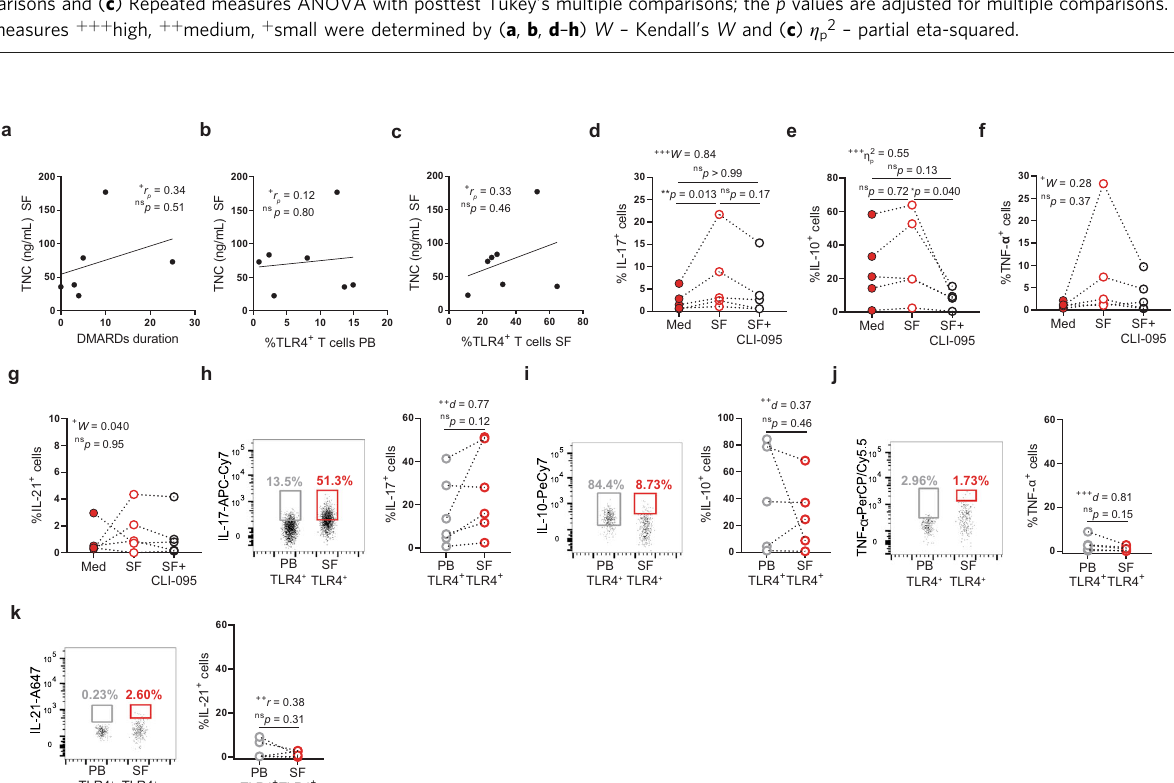
Fig. 9 Direct recognition of LPS by TLR4 + T cells reprograms their cytokine program. FACS-puri fi ed CD3 high CD4 high T cells from freshly obtained peripheral blood were cultured for 18 hours and stimulated with either α -CD3 and α -ICOS (TCR ICOS); α -CD3, α -ICOS, and LPS (TCR ICOS LPS); LPS alone; or left unstimulated (unst). a Frequency and b Δ MFI of IL-21 production by TLR4 + T cells ( n = 7 RA patients). c Frequency and d Δ MFI of IL-10 production by TLR4 + T cells ( n = 7 RA patients). e Frequency and f Δ MFI of TNF- α production by TLR4 + T cells ( n = 5 RA patients). g Frequency and h Δ MFI of IL-17 production by TLR4 + T cells ( n = 12 RA patients). Δ MFI was calculated by subtracting the fl uorescence intensity minus one (FMO) from median fl uorescence intensity (MFI) for each given marker. Data are presented as median ± IQR and mean ( + ), for parametric statistical tests, median ± IQR, for